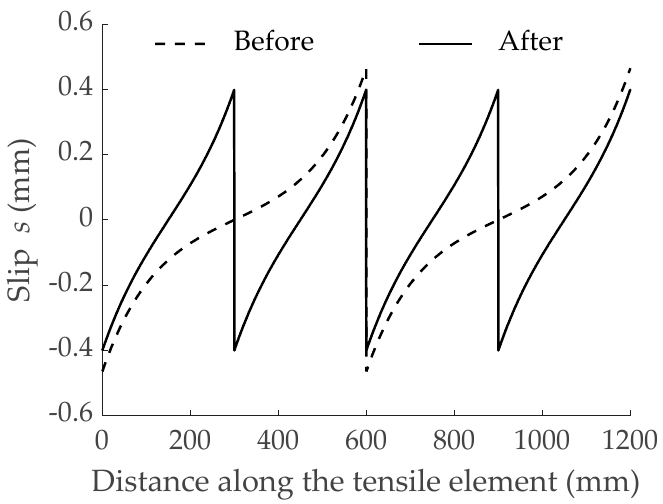
Figure 6. Effect of GFRP reinforcing bar surface configuration on: ( a ) Reinforcement strain distribution; ( b ) Normalized reinforcement strain distribution. Figure 7. Distribution of slip before and after the second crack formation for the specimen reinforced with bar G1.